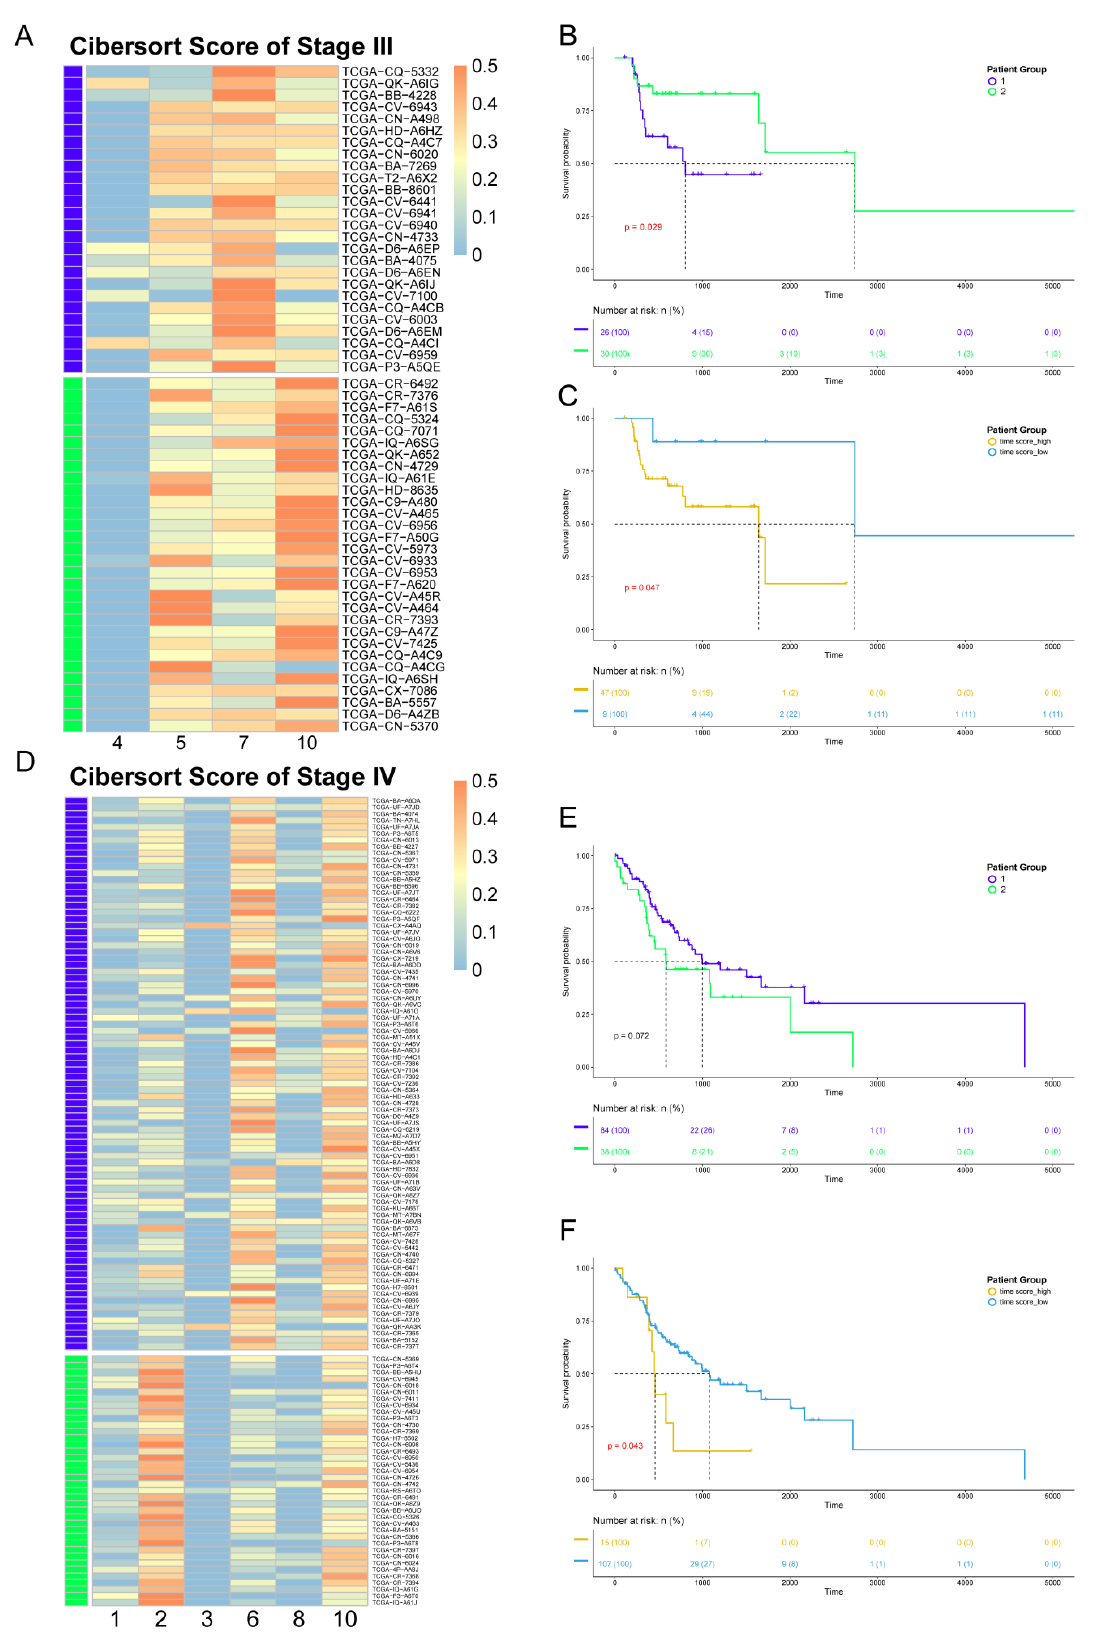
Figure 5. Association between heterogeneity and clinical prognosis. ( A , D ) The results of CIBERSORT. Patients were divided into two groups by hierarchical clustering. Patients in stage III are shown